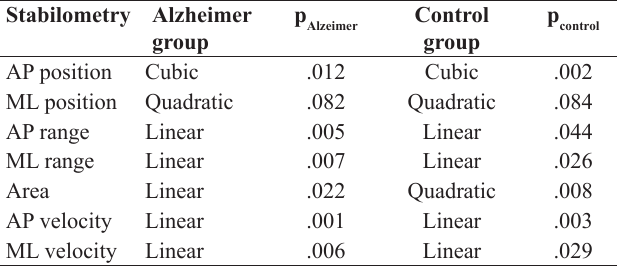
Table 3. Contrast upon the paired group